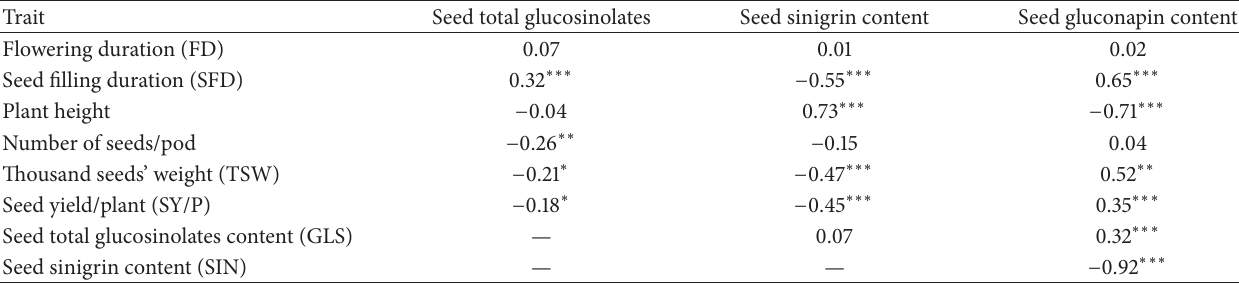
Table 3: Correlations between seed total glucosinolates, sinigrin, and gluconapin and agronomical traits measured on a collection of 190